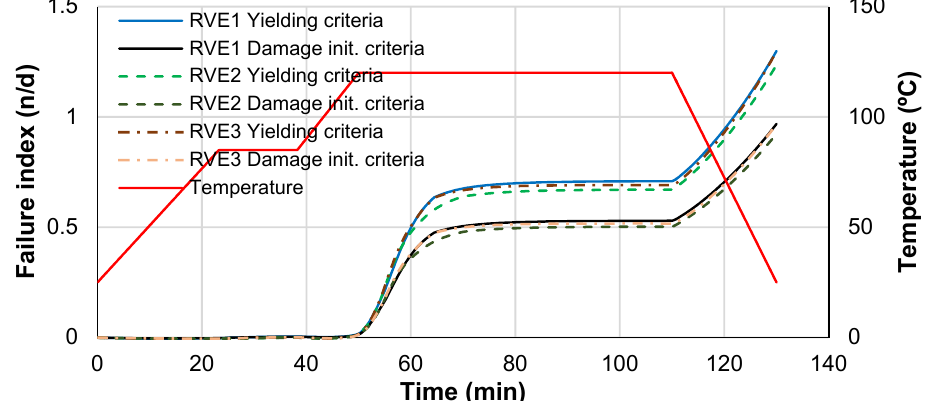
Figure 12. Failure indexes for yielding and damage initiation.